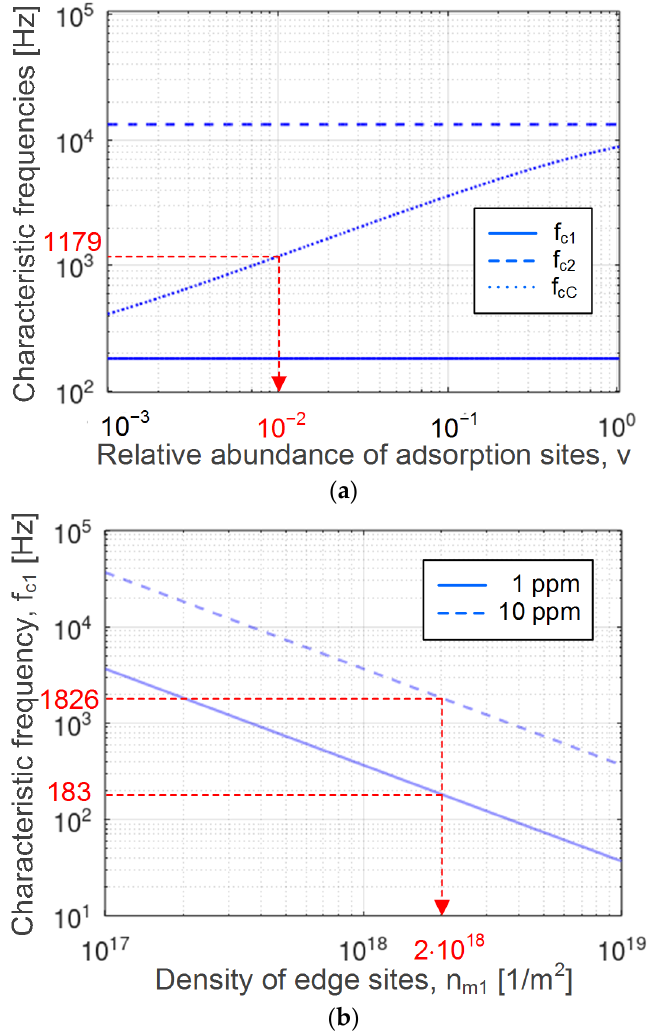
Figure 2. ( a ) Dependence of the noise spectrum characteristic frequencies on the ratio of the numbers of edge and basal plane sites, v (the other parameter values are the same as for Figure 1). It is shown that the value f cC = 1179 Hz unambiguously indicates that v = 0.01 (in accordance with the red curves in Figure 1), ( b ) Characteristic frequency corresponding to the spectrum noise component that originates from the fluctuations of the number of gas particles on edge adsorption sites, as a function of the density of the sites, for two different CO 2 concentrations. The values of f c 1 for different concentrations uniquely determine the density of edge sites on the same sensing surface, as shown in red.